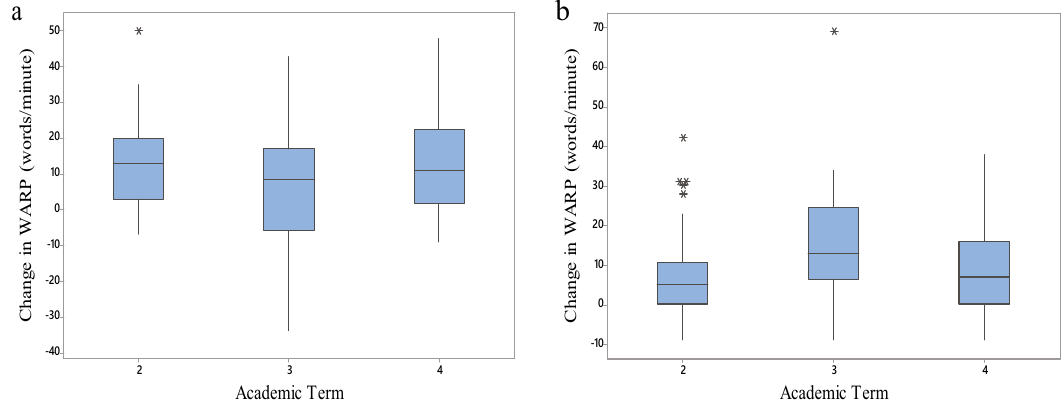
Fig. 2 Change in reading fl uency (term-by-term) for schools following each condition sequence. Panel ( a ) shows classes following the Enclosed/Open/Enclosed sequence and Panel (b) shows classes following the Open/Enclosed/Open sequence. The centre line of each boxplot represents the data median and the bounds of the box show the interquartile range. The whiskers represent the bottom 25% and top 25% of the data range — excluding outliers which are represented by an asterisk.